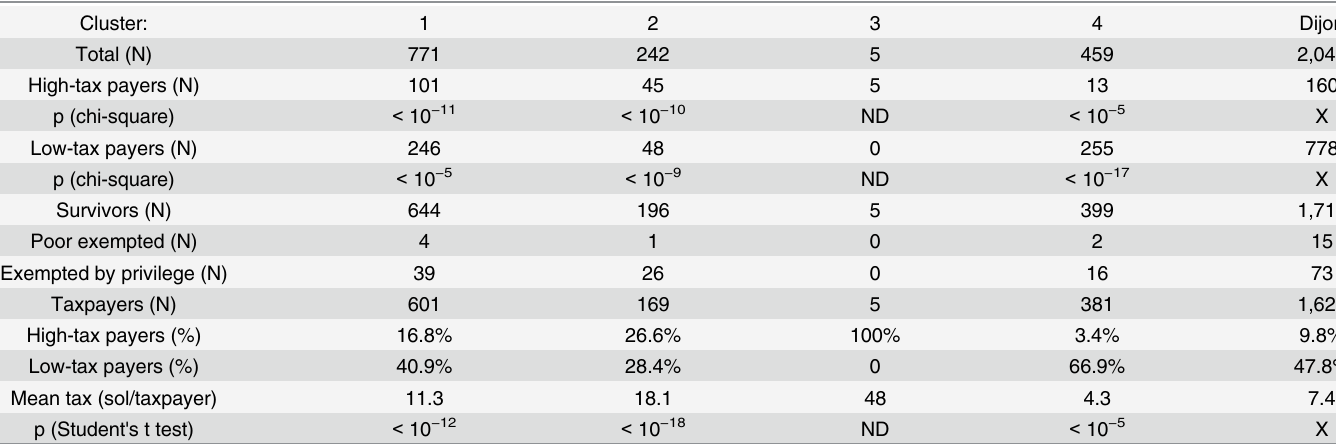
Table 2. Characteristics in the tax level-based